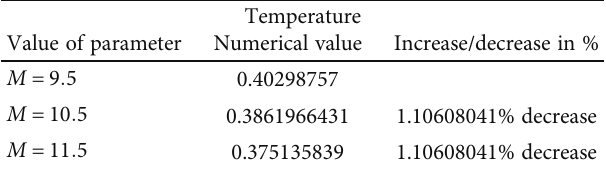
Table 4: Variability of the curve when Y = 1 in Figure 7(b).